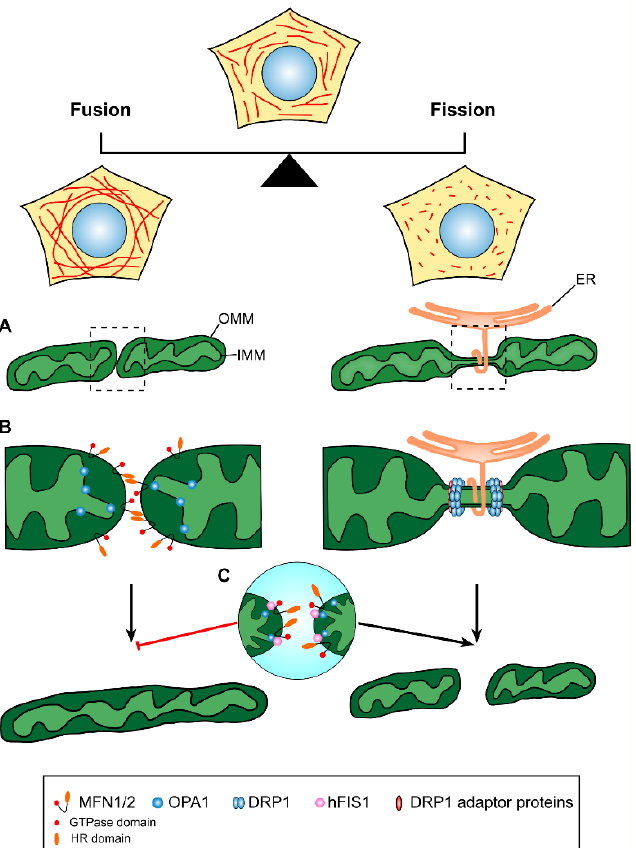
Figure 1. Schematic illustration of mitochondrial fusion and fission. Mitochondria are dynamic organelles undergoing coordinated cycles of mitochondrial fusion and fission. A balance in the processes of mitochondrial dynamics maintains mitochondrial network homeostasis, which is central to proper cell function. ( A ) Mitochondrial fusion (left) involves the merging of two originally distinct mitochondria into a single organelle, while mitochondrial fission (right) describes the division of a single mitochondrion in two or more individual mitochondrial units, a process that involves a membrane preconstriction step at the ER–mitochondria contact sites. ( B ) OMM tethering and fusion are promoted by the formation of MFN1/MFN2 homotypic or heterotypic complexes and the physical interaction of the mitofusins GTPase and HR domains, while IMM fusion is mediated by the inner-membrane-anchored protein OPA1. Mitochondrial fission is mainly regulated by the DRP1 protein, which is recruited to the mitochondrial division site by interacting with the adaptor proteins MFF, MiD49 and MiD51. As indicated, the ER has a prominent role in delimiting the exact site of mitochondrial division by wrapping itself around the mitochondrial tubule prior to the oligomerization of multiple DRP1 molecules in a ring-shaped structure that further constricts the membrane and reinforces mitochondrial scission. ( C ) hFIS1 interacts with the fusion mediators MFN1, MFN2 and OPA1, blocks their GTPase function and shifts the balance of mitochondrial dynamics towards fission. OMM, outer mitochondrial membrane; IMM, inner mitochondrial membrane; HR, heptad